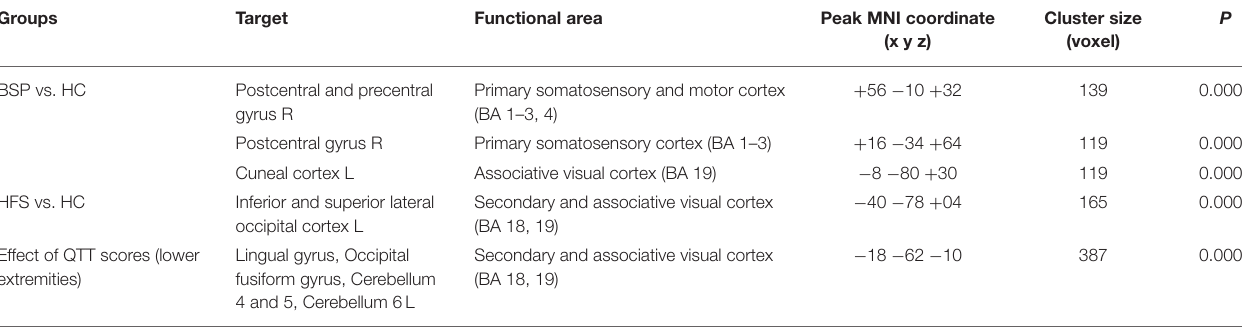
TABLE 2 | Increased functional connectivity in different groups for seed ROI with the anterior cerebellar network.